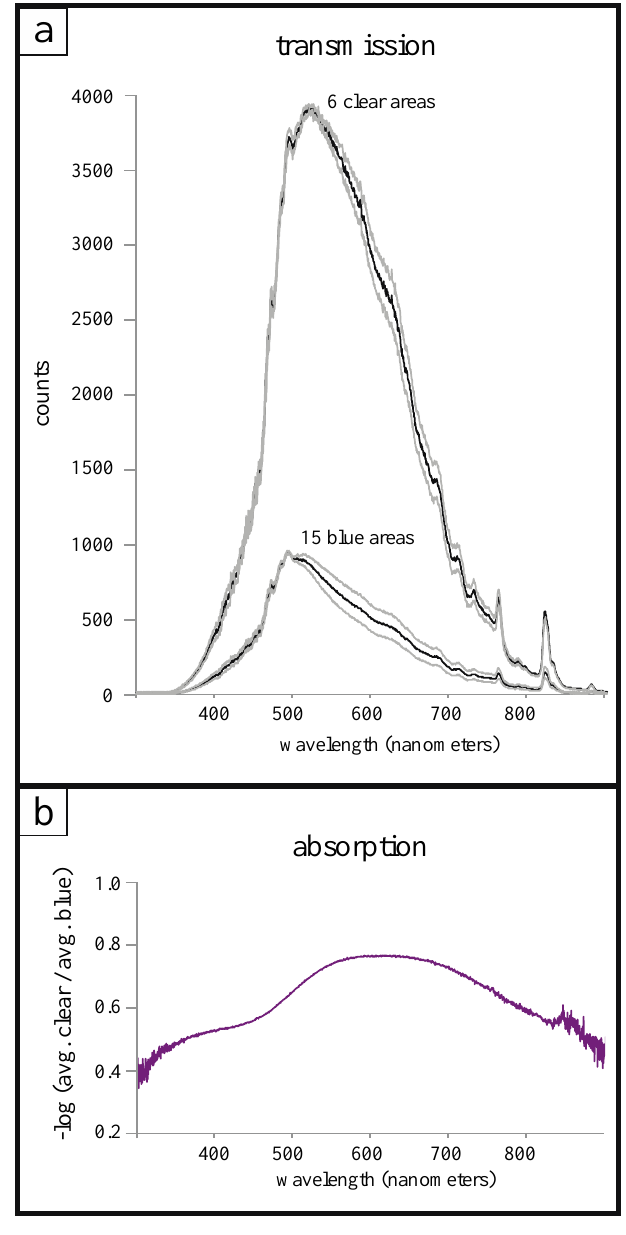
Figure 7. UV-Vis-near IR optical spectra from 15 blue sapphires and 6 clear corundum grains, ( a ) transmission data from 300 to 900 nm, ( b ) absorption data over the same wavelength range. See text for further discussion.